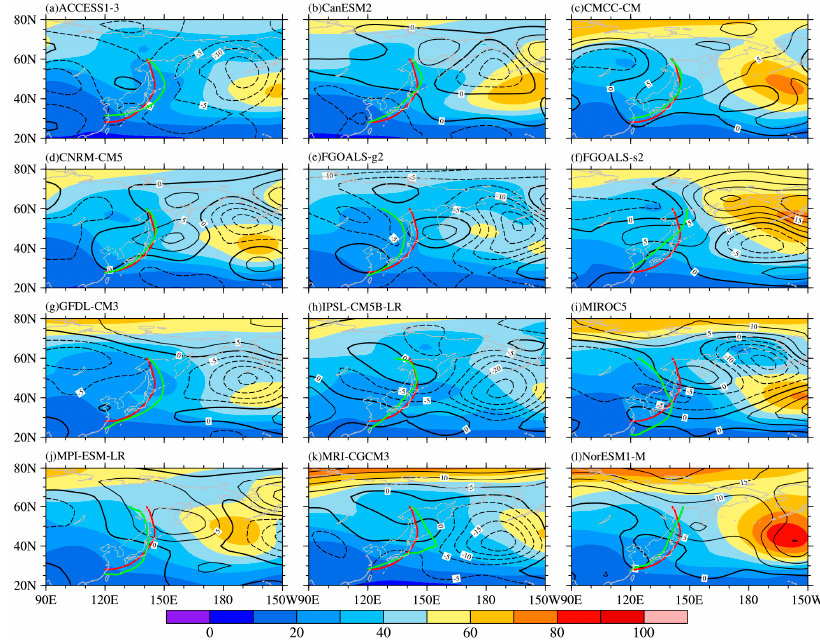
Figure 3. Interannual standard deviation of the geopotential height at 500 hPa in the boreal winter for individual CMIP5 models (colors, gpm) and its difference from the observations (contours, interval is 5 gpm). The red (green) lines represent the trough line in the observations (individual CMIP5 models). ( a – l ) represent different CMIP5 models as indicated at top left in each panel.